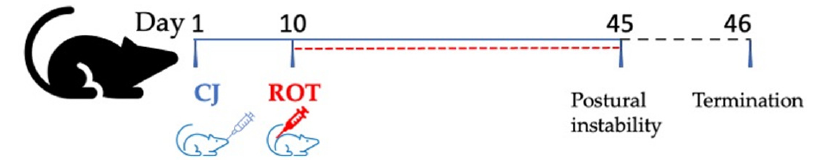
Figure 1. A scheme of experimental design